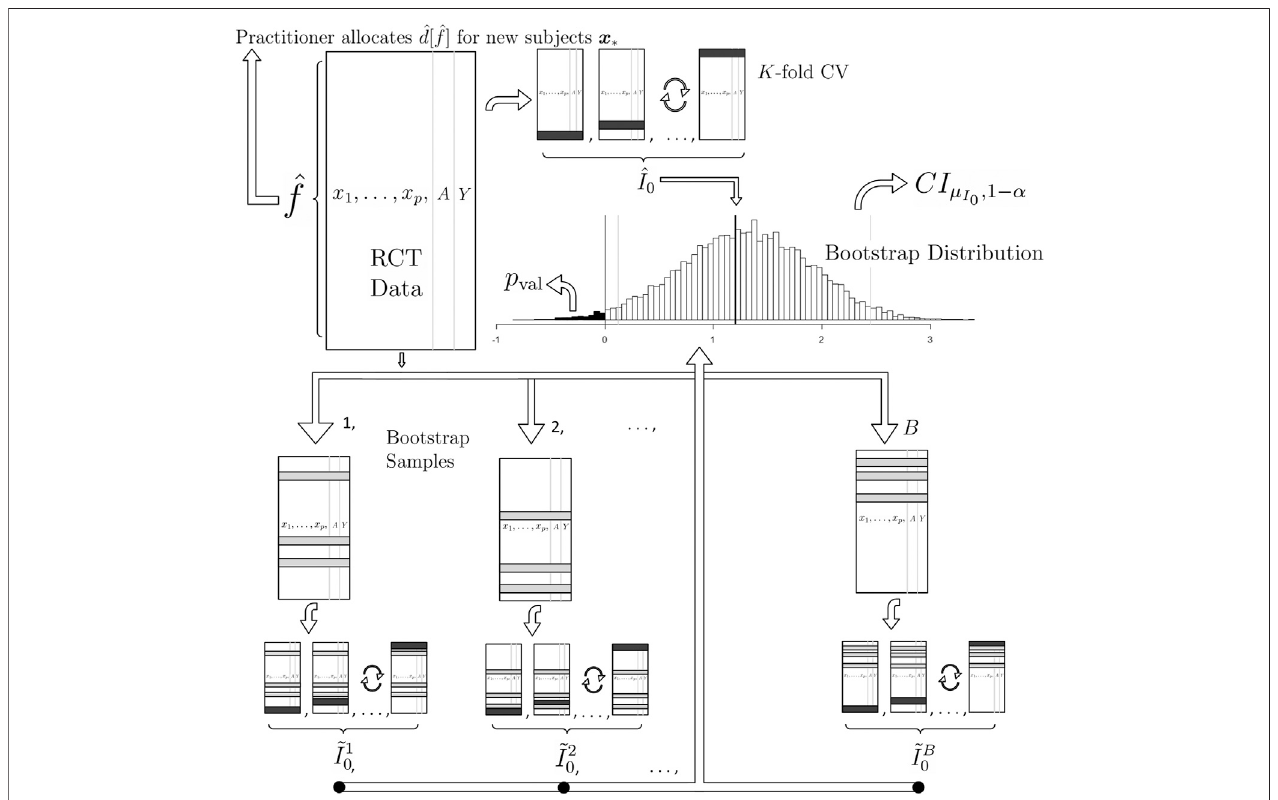
FIGURE1| Agraphicalillustrationof(1)ourproposedmethodforestimationand(2)ourproposedmethodforinferenceonthepopulationmeanimprovementofan allocationprocedureand(3)ourproposedfutureallocationprocedure(topleftoftheillustration).Tocomputethebestestimateoftheimprovement (cid:12) I 0 ,theRCTdatagoes throughthe K -foldcrossvalidationprocedureof Section3.4 (depictedinthetopcenter).Theblackslicesofthedataframerepresentthetestdata.Todrawinference,we employ the non-parametric bootstrap procedure of Section 3.5 by sampling the RCT data with replacement and repeating the K -fold CV to produce (cid:12) I 1 0 , (cid:12) I 2 0 , ... , (cid:12) I B 0 (bottom).Thegrayslicesofthedataframerepresenttheduplicaterowsintheoriginaldataduetosamplingwithreplacement.Thecon fi denceintervalandsigni fi canceof ≤ 0 is computed from the bootstrap distribution (middle center). Finally, the practitioner receives (cid:12) f which is built with the complete RCT data (top left). H 0 : μ I 0